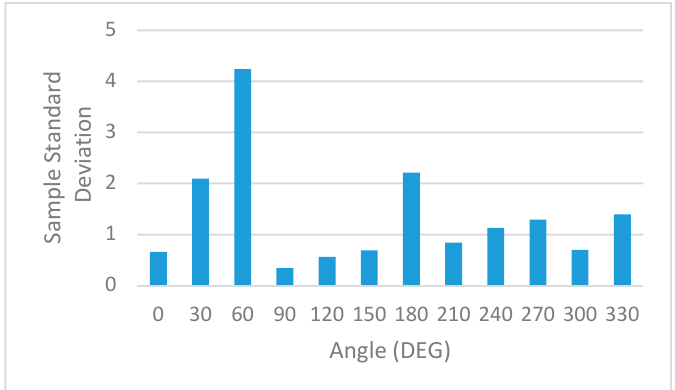
Figure 22. Statistical analysis. Mean RSSI value of measurements. Sensors 2019 , 19 , x FOR PEER REVIEW